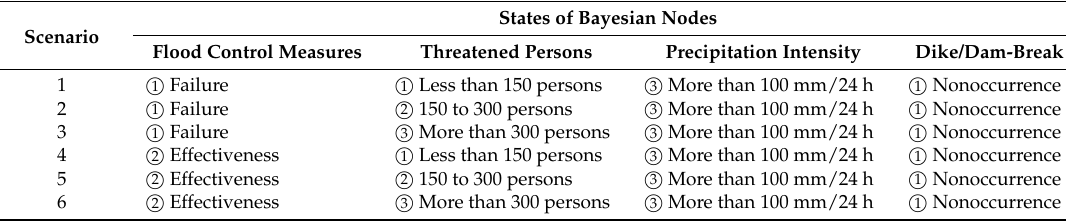
Table 6. Given state evidences of some BN nodes.